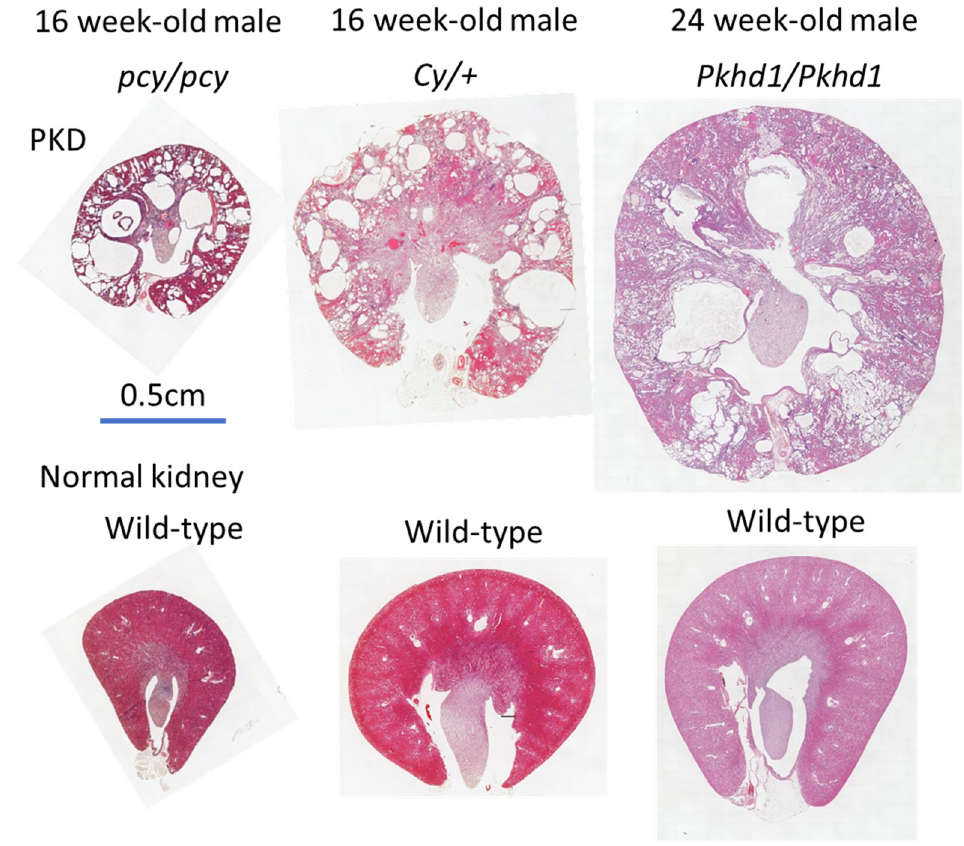
Figure 1. Macrophotographs in the hematoxylin and eosin-stained kidneys of pcy mice and Cy rats and the PAS-stained kidneys of PCK rats. and the PAS-stained kidneys of PCK